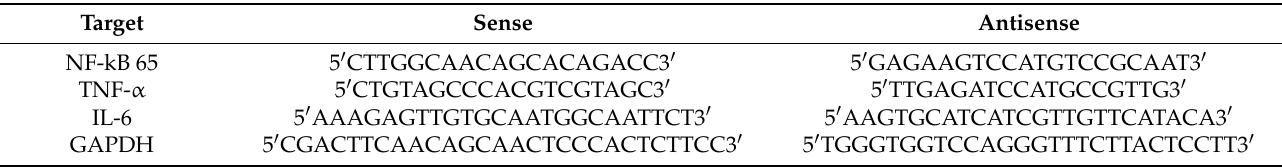
Table 1. Primer sequences for